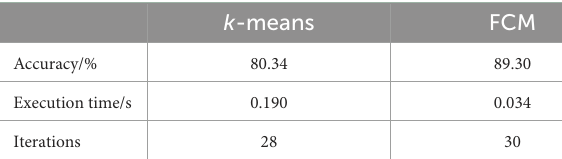
TABLE 1 Comparison of clustering